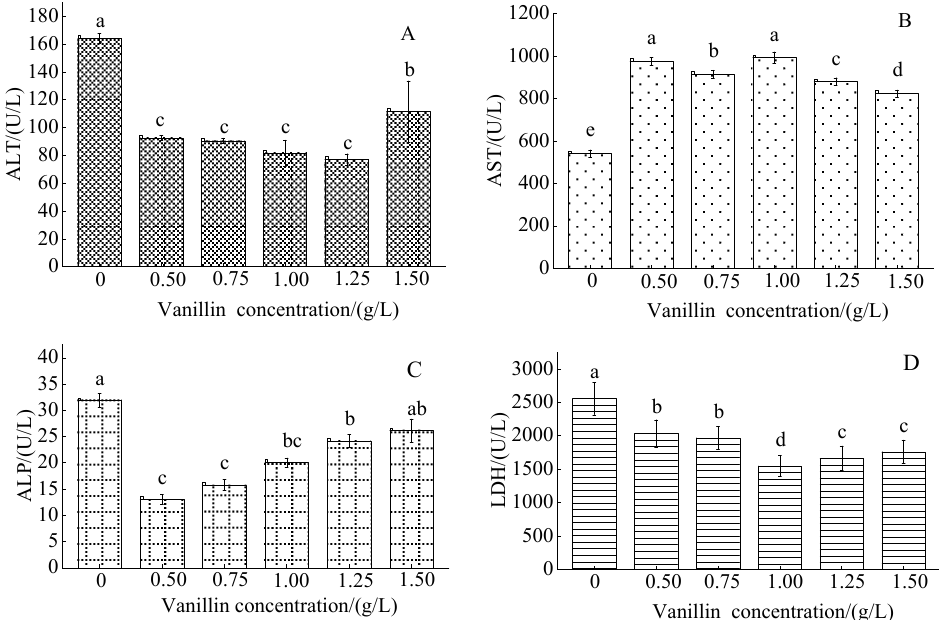
Figure 3. Effect of vanillin concentration on serum enzyme concentrations in crucian carp: ( A ) alanine aminotransferase (ALT); ( B ) aspartate aminotransferase (AST); ( C ) alkaline phosphatase (ALP); and ( D ) lactate dehydrogenase (LDH). Different letters above the columns indicate a significant difference ( p < 0.05); the same letter indicates no significant difference ( p > 0.05).